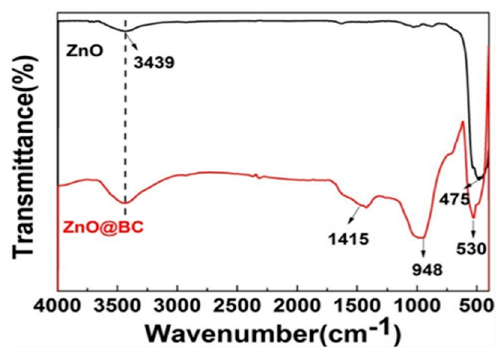
Figure 4. FTIR spectra of ZnO@BC.